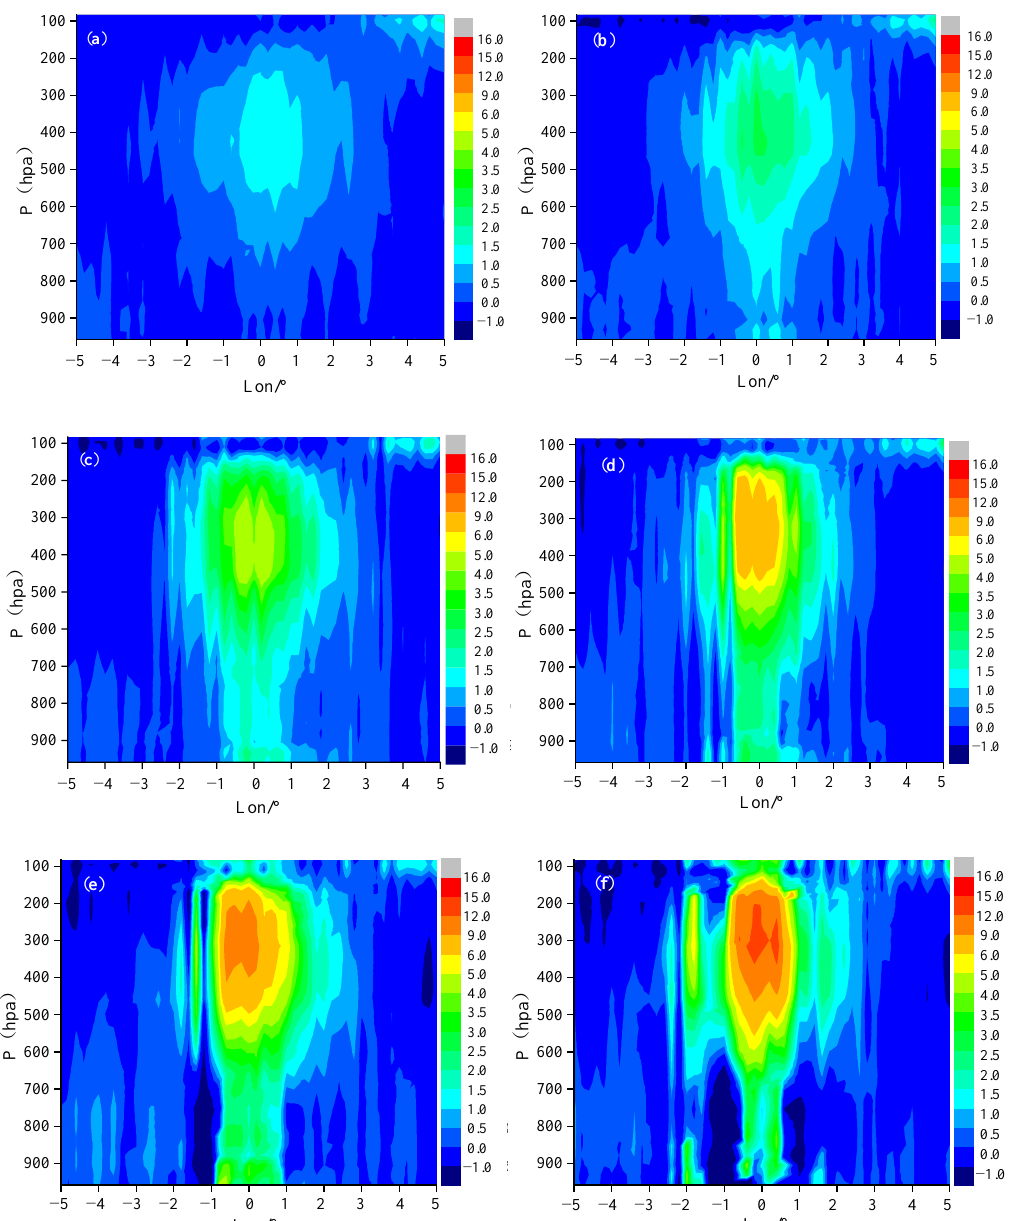
Figure 5. Temperature anomaly (K) vertical profiles by TC intensity: ( a ) TD, ( b ) TS, ( c ) STS, ( d ) TY, ( e ) STY, and ( f ) Super TY.